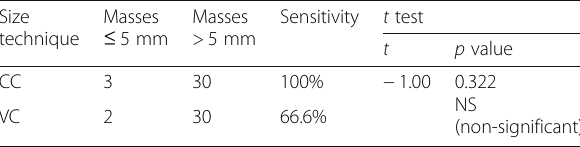
Table 6 The side findings as revealed by the MPR images Side findings